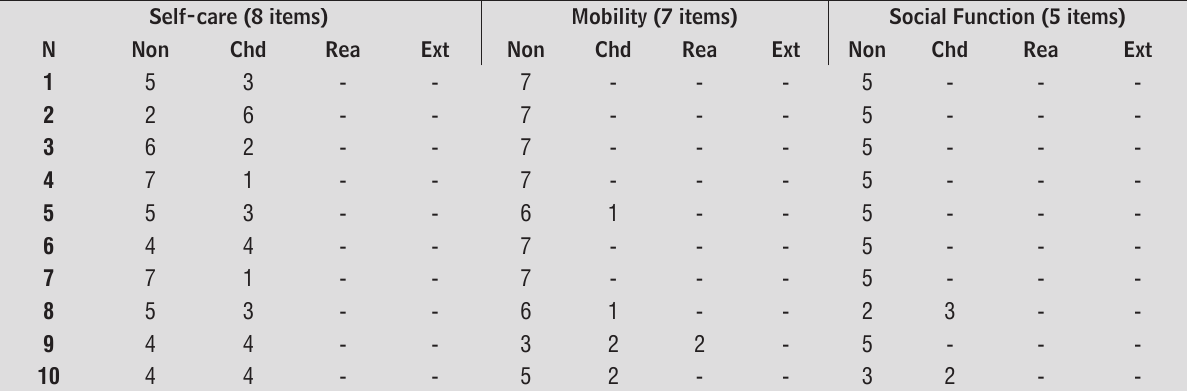
Table 3 - Frequency of responses concerning Part III - Change in Environment for Down group (n =